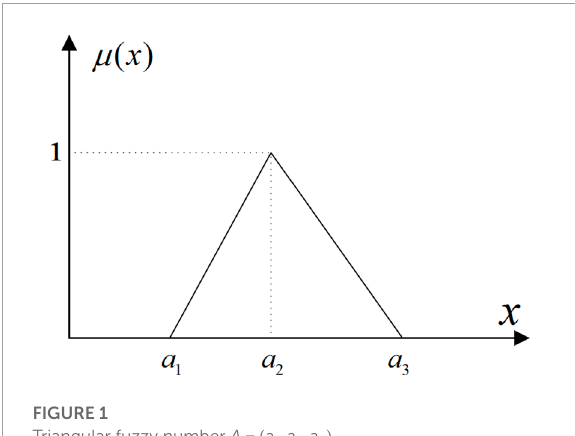
FIGURE 1 Triangular fuzzy number A = ( a 1 , a 2 , a 3 )